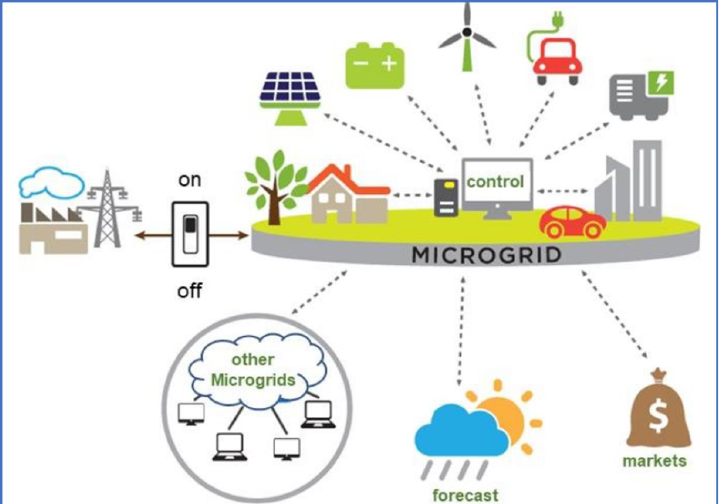
Figure 3. A typical MG architecture [2].